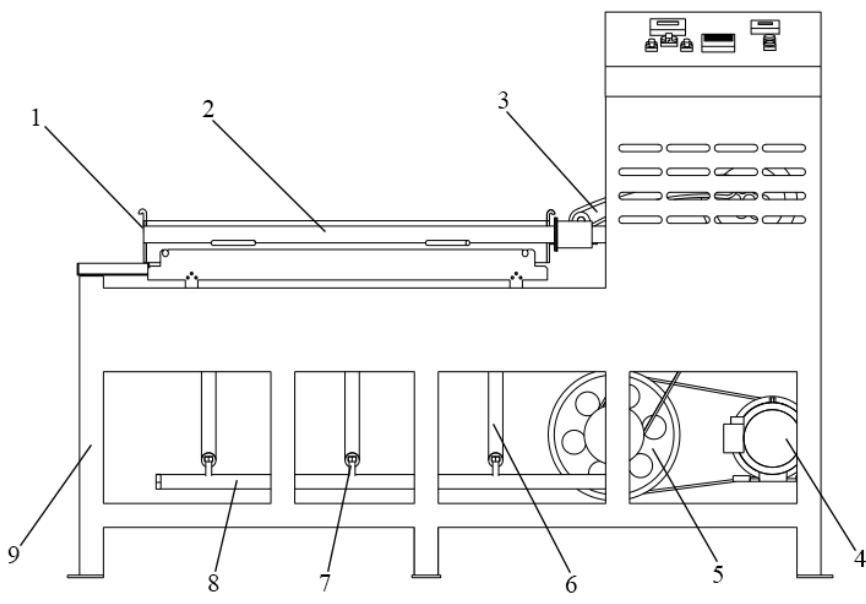
Figure 1. Schematic diagram of structure of tea de-enzyming and carding machine. 1. Pot rack. 2. Multi-tank pot. 3. Connecting rod. 4. Motor. 5. Crank slider mechanism. 6. Gas installations. 7. Gas control valve. 8. Gas supply pipe. 9. Rack.